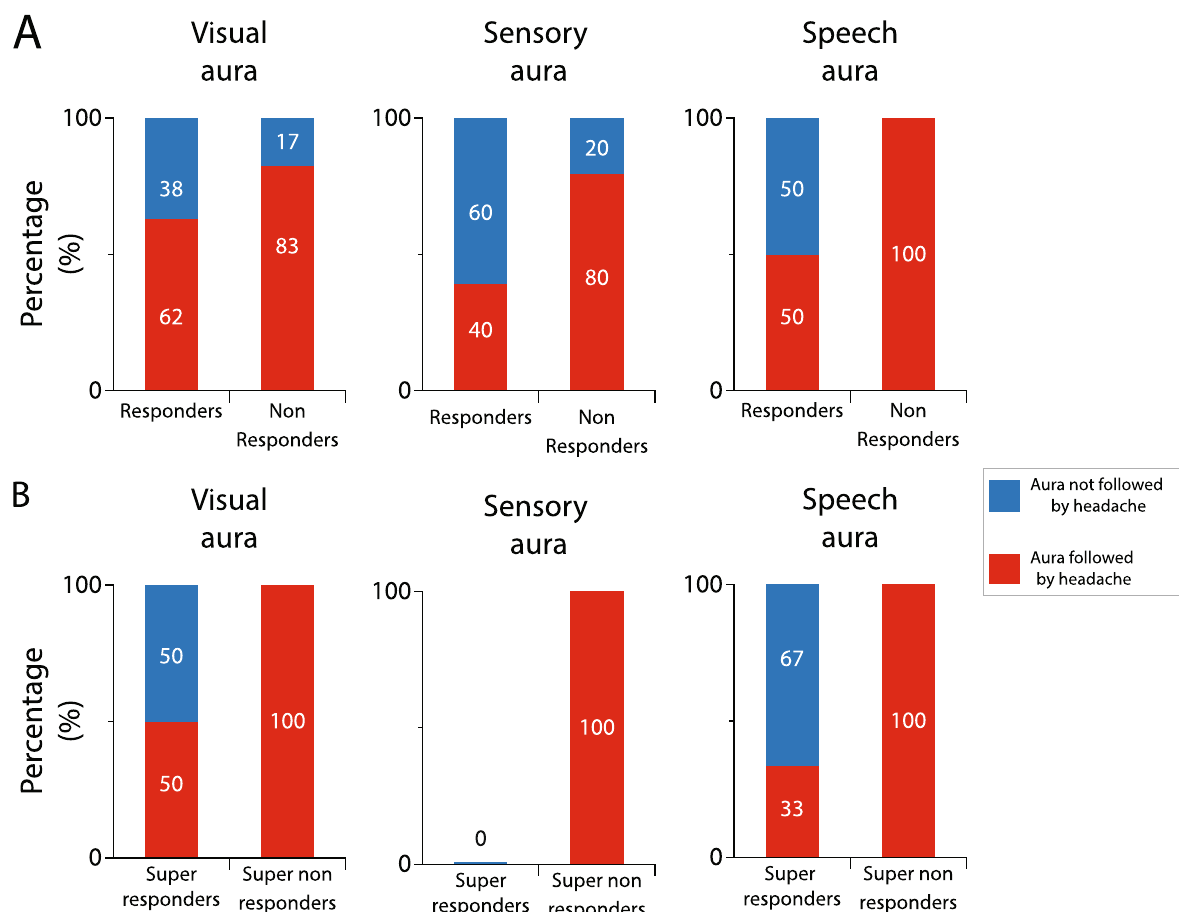
Fig. 8 Galcanezumab effects on incidence of headache after occurrence of aura in responders vs. non‑responders ( A ), and super‑responders vs. super non‑responders ( B ). Complete absence of effect in the super non‑responders suggest the galcanezumab ability to reduce incidence of headache after aura is secondary to the reduction in migraine days per